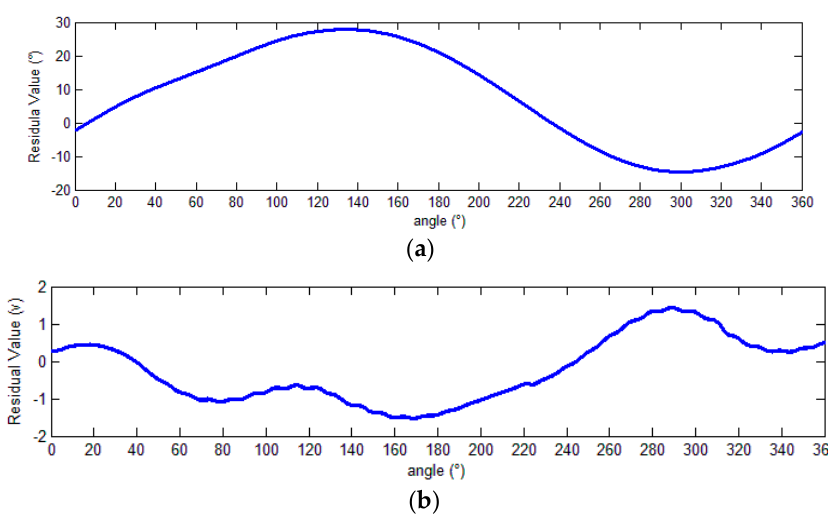
Figure 22. Demodulation errors. ( a ) Demodulation error before calibration; ( b ) demodulation error after calibration.